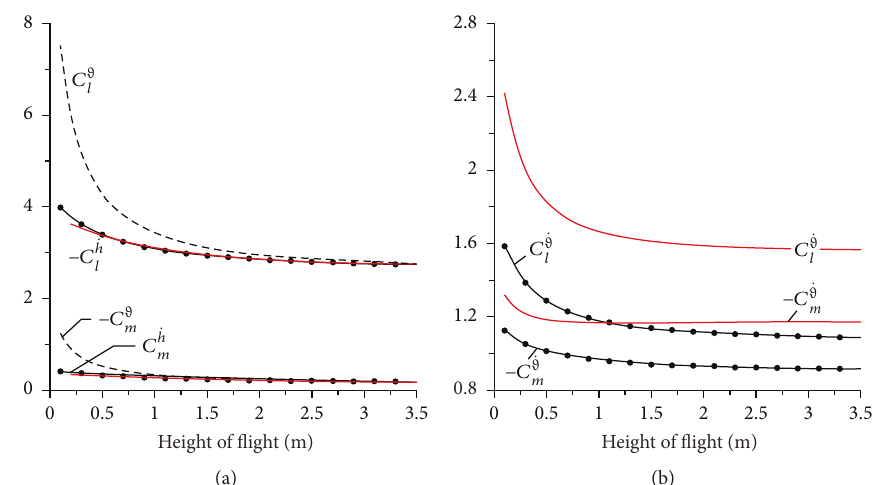
Figure 9: In fl uence of the ground e ff ect on aerodynamic derivatives for the Lippisch con fi guration craft. Red lines: full unsteady calculations; black lines with circles: quasi-steady